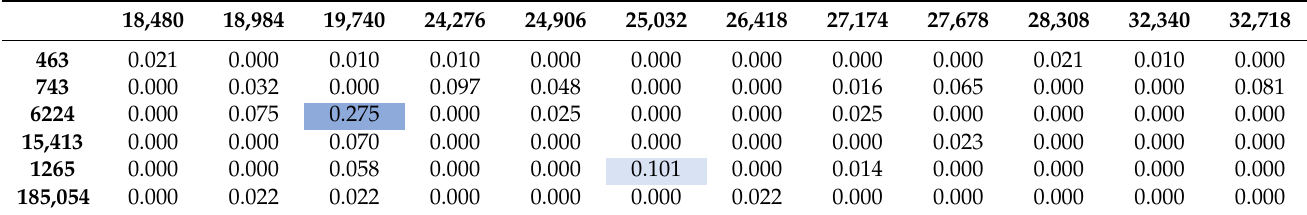
Table A1. An example from the original data of a client’s normalized vector and his/her 5 nearest neighbors. Rows and columns represent clients and restaurants, respectively. Cells values mean the percentage of the orders realized by the client to the restaurant. The bluer the cell, the bigger the